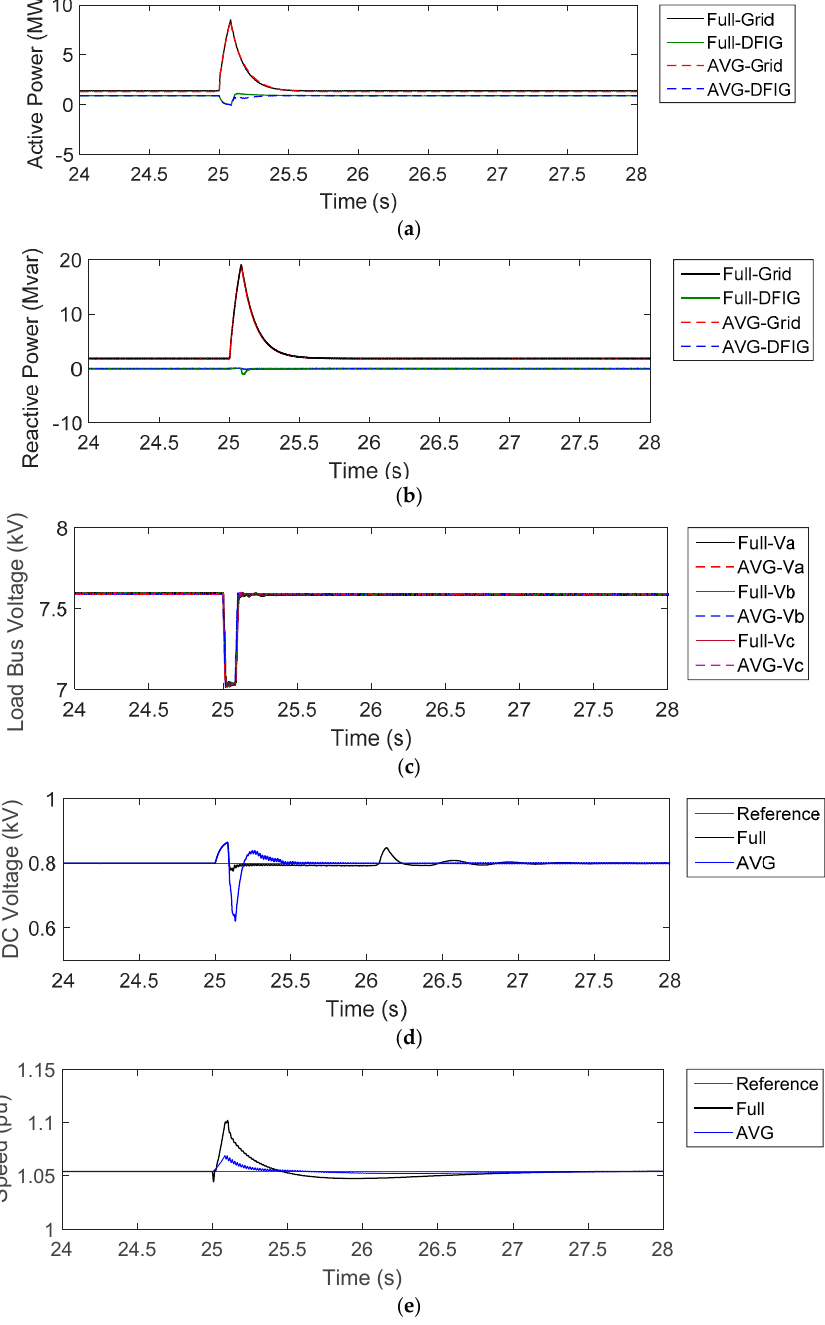
Figure 8. Outputs with 3-phase to ground fault of 0.1 Ω at the DFIG terminal with balanced loads: ( a ) active power outputs, ( b ) reactive power outputs, ( c ) load bus voltage, ( d ) DC voltage, ( e ) DFIG speed.